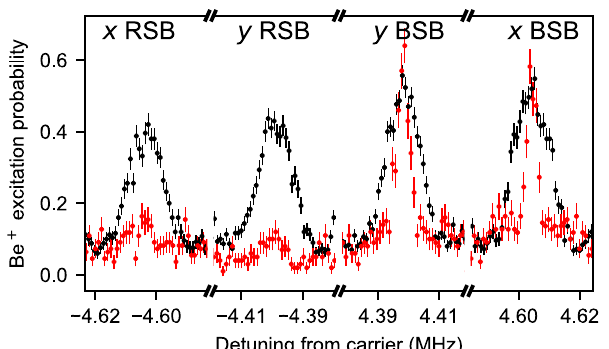
FIG. 3. WCR motional sidebands of the two-ion crystal before (black) and after (red) resolved sideband cooling. The transition is driven on the Ar 13 þ ion, whose final state is read out from the Be þ ion using quantum-logic spectroscopy. The error bars are statistical only, governed by quantum projection noise. The observed difference in the full-width-at-half-maximum values between the two cases is caused by the different lengths of the interrogation pulse used, which were adjusted in each case to produce the highest possible contrast. The scans have been recentered for presentation, correcting for small drifts in the secular frequencies.